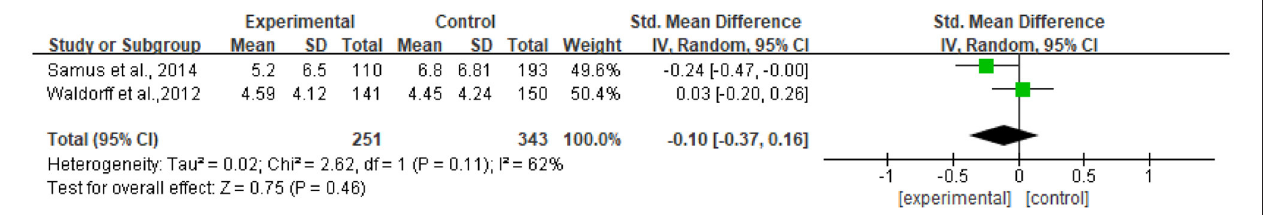
FIGURE 9 | Effect size of the intervention group vs. the control group on